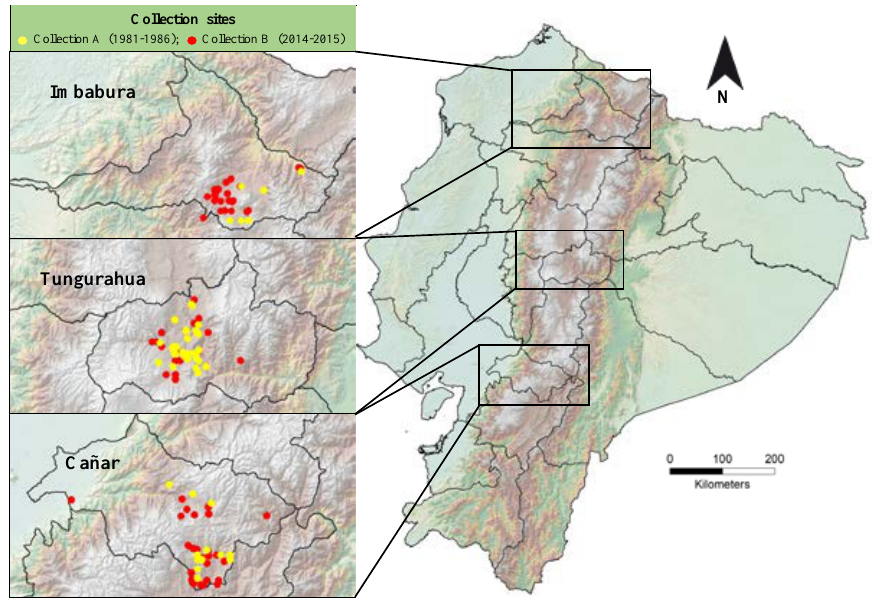
Figure 1. Geographical map of Ecuador indicating the collection sites of black amaranth accessions in the provinces of Imbabura, Tungurahua, and Cañar during 1981–1986 (Collection A) and 2014–2015 (Collection B).